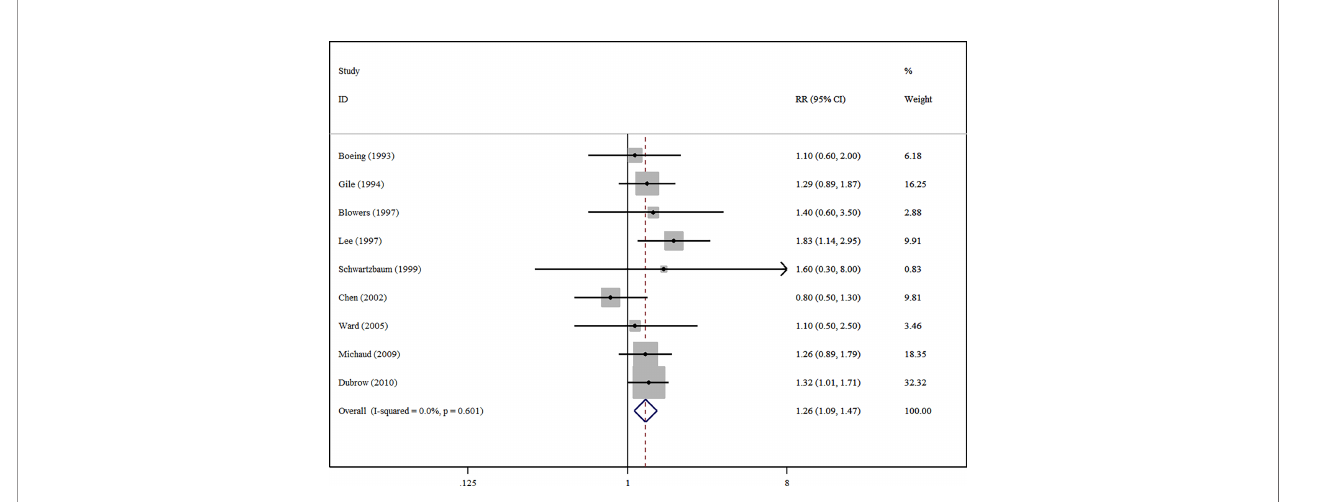
FIGURE 2 | A forest plot showing risk estimates of the association between nitrite and glioma in adults.